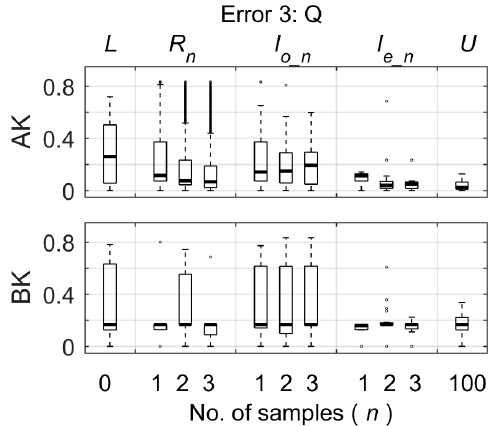
Figure 6. Box plots of the relative parameter error (absolute difference between the calibrated and real parameter value divided by the initial parameter range used for calibration) for parameters AK and BK for the systematic error in streamflow (Error 3) for the medium event and PI, showing the effect of the sampling strategy and the number of samples on parameter identifiability.